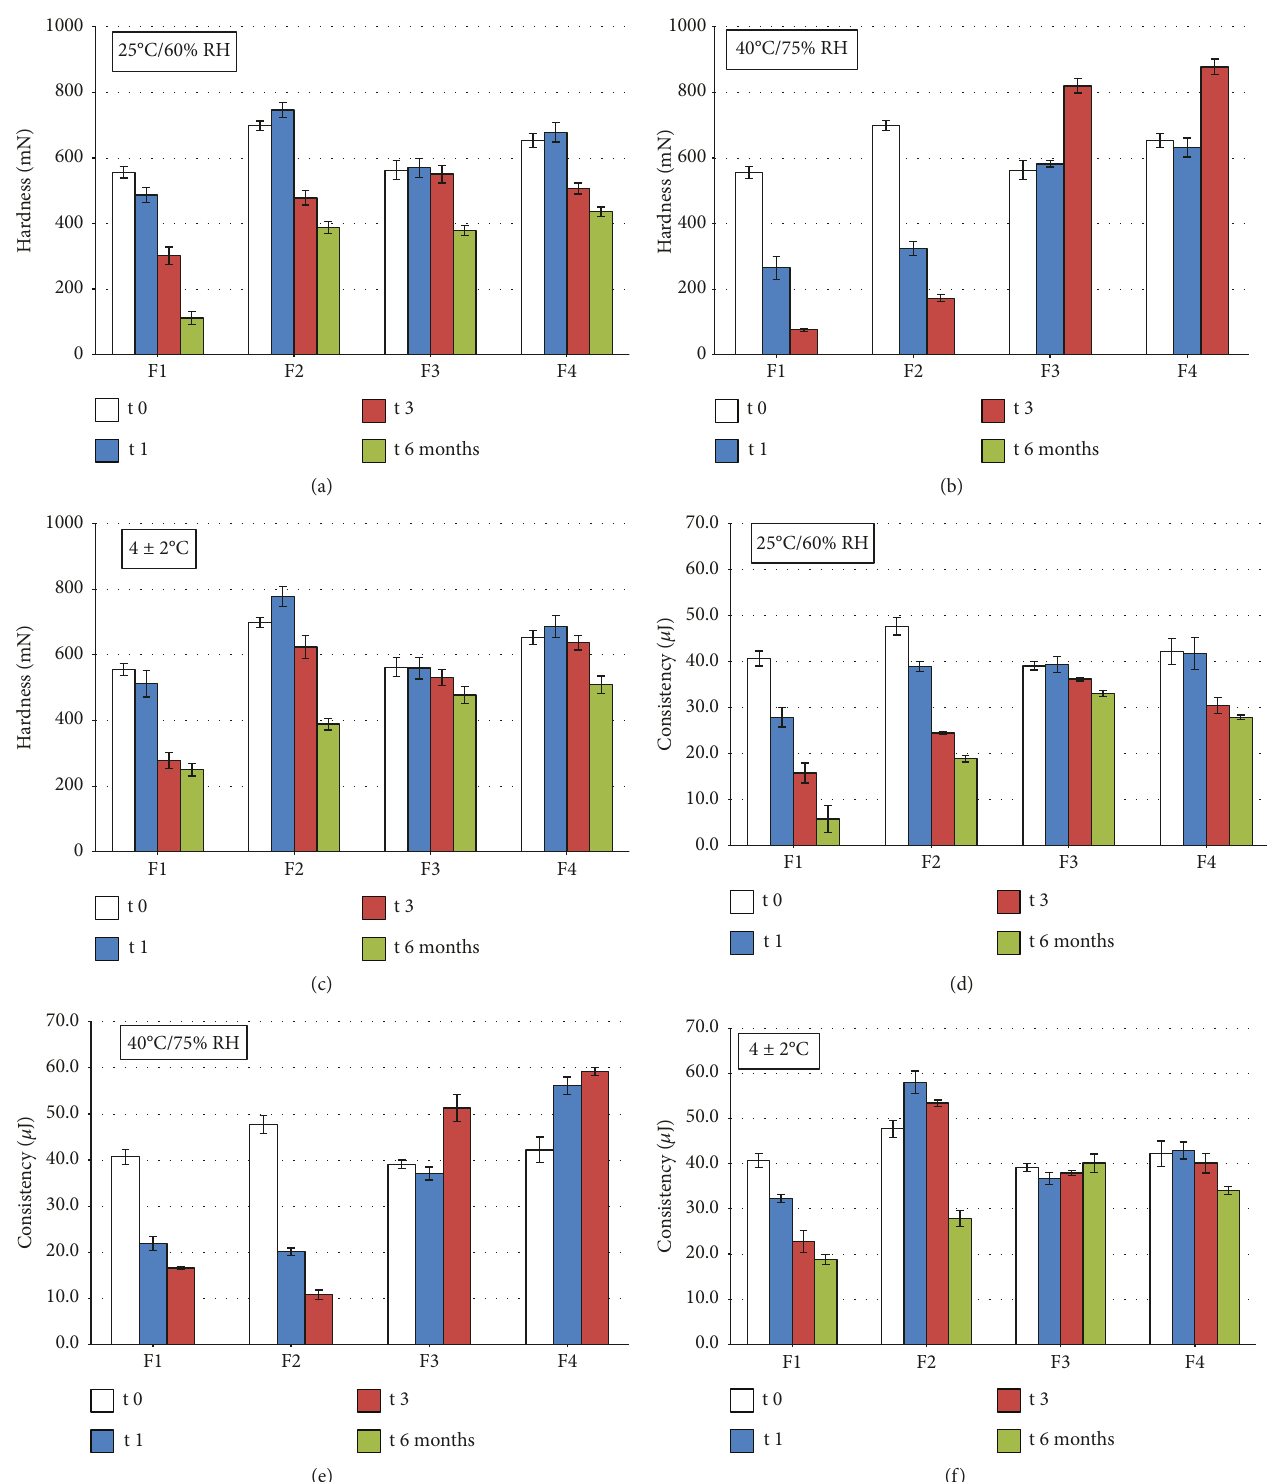
Figure 3: Hardness (a – c) and consistency (d – f) of hydrogels with unmodi fi ed CS (F1, F2) or with bGP-crosslinked CS (F3, F4) directly after preparation and upon 6-month storage at ambient (a, d), accelerated (b, e), and refrigerated conditions (c, f) ( n = 3 , mean ±